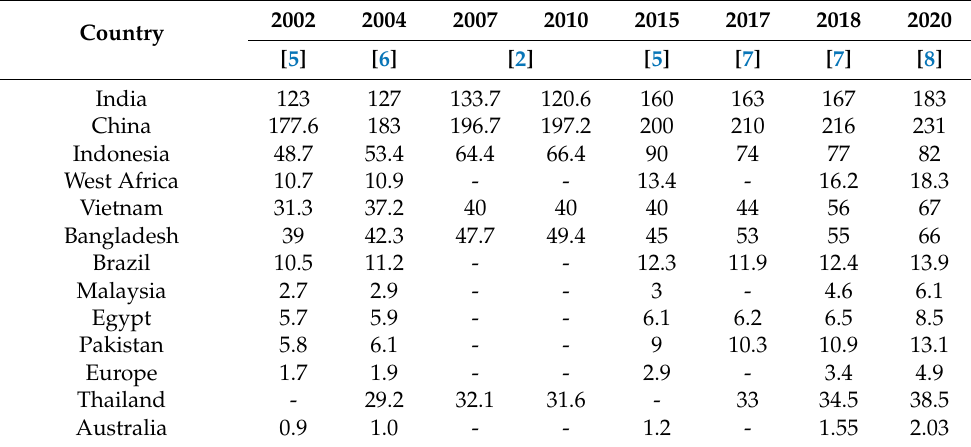
Table 1. Rice production in different countries (million tons).